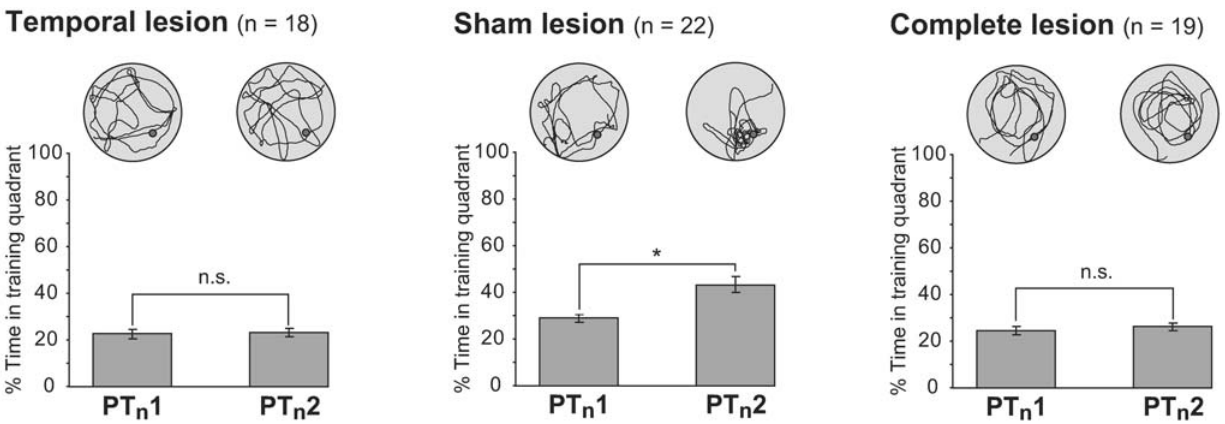
Figure 6. Novel Context Learning Percentage time spent in the target quadrant containing the escape platform during one-trial new learning in a different pool. * p , 0.05; n.s. = nonsignificant; comparison of percentage time spent in training zone during PT n 1 and PT n 2; paired-sample t-tests. New learning was observed only in sham-lesioned rats. DOI: